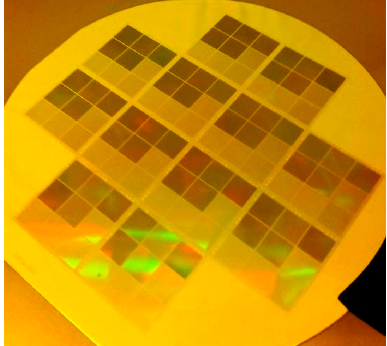
Figure 1. Wafer level fabrication of large-area metamaterial absorbers fabricated over a 4-inch silicon